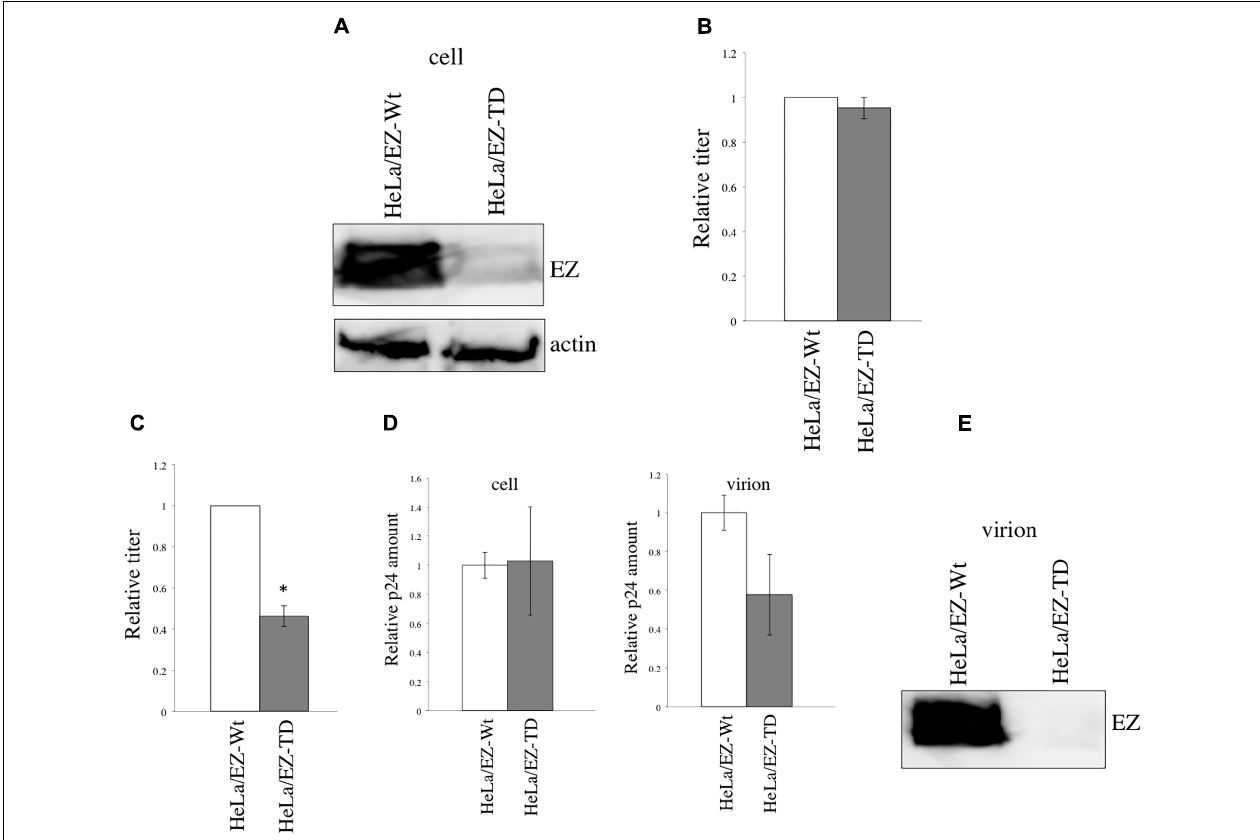
FIGURE 7 | EZ-TD level is reduced during the maintenance of EZ-TD-expressing cells. (A) HeLa/CD4 cells stably expressing EZ-Wt or EZ-TD were cultured for long time, and cell lysates were prepared from the cells. The cell lysates were analyzed by western blotting. (B) Transduction titers of X4-tropic HIV-1 Env-containing HIV-1 vector were measured in the long-cultured cells. Transduction titers of the EZ-Wt-expressing cells were always set to 1, and relative values to transduction titers in the EZ-Wt-expressing cells are indicated. Error bars show standard deviations. (C) HeLa/CD4 cells expressing EZ-Wt or EZ-TD were transfected by the X4-tropic HIV-1 vector construction plasmids. Culture supernatants were inoculated to HeLa/CD4 cells. Transduction titers of culture supernatants from the EZ-Wt-expressing cells were always set to 1, and relative values to transduction titers from the EZ-Wt-expressing cells are indicated. Error bars show standard deviations. An asterisk indicates statistically significant difference. (D) The p24 levels in cell lysates or culture supernatants were measured by ELISA. Relative values to p24 amounts in the EZ-Wt-expressing cells were indicated. Error bars show standard deviations. (E) Virion pellets from the transfected cells were analyzed by western blotting using the VSV-G epitope